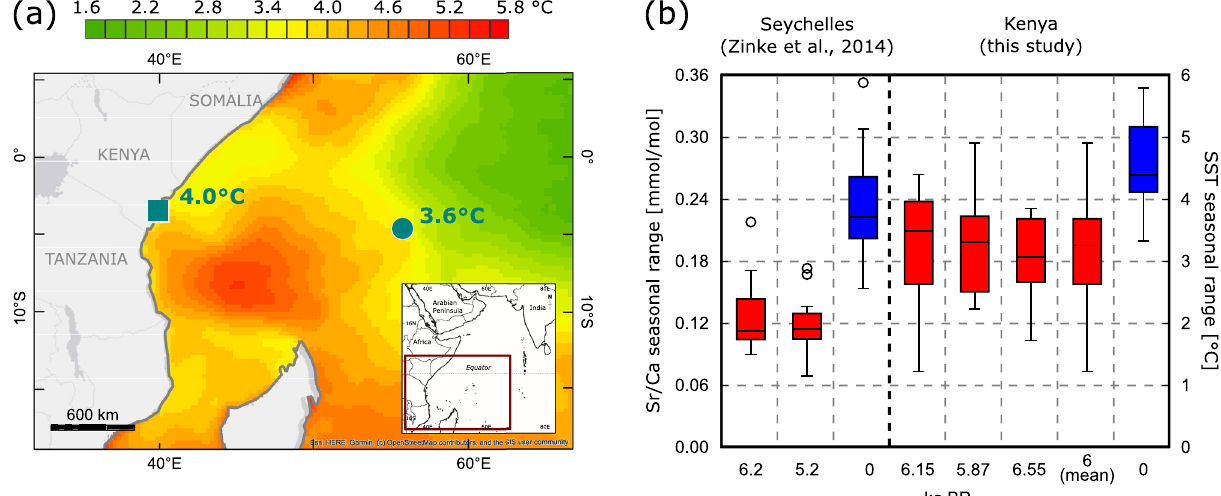
Figure 6. SST seasonality on the WIO, present-day and MH. ( a ) Map showing amplitudes of mean seasonal SST cycles in the WIO (1987–2002; AVHRR SST 25 ). Charts computed using OpenStreetMap, date accessed: 31 March 2021. SST amplitudes average 4.0 °C (Kenya: blue square) and 3.6 °C (Seychelles: blue dot). ( b ) Boxplots comparing present-day and mid-Holocene seasonal amplitudes of coral Sr/Ca from the Seychelles 17 and Kenya (this study). Median seasonal amplitudes are shown by the black solid line and boxes include 60% of the data. Whiskers indicate maximum ranges, open circles outliers. Corresponding SST ranges are shown on the right axis calculated using -0.06 mmol/mol per 1 °C 26,27